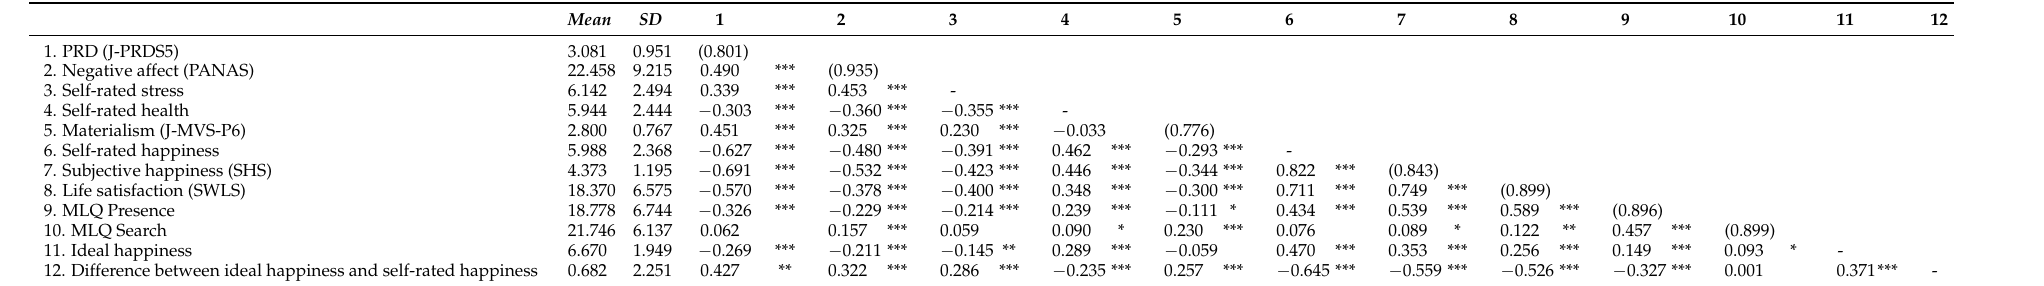
Table 3. Correlation between PRD and variables related to well-being.